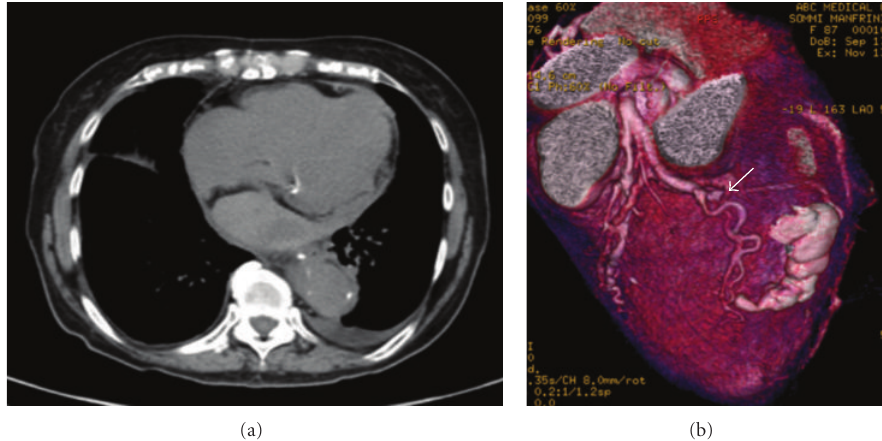
Figure 3: In (a) an important thickening of the pericardium containing the hemopericardium is seen and in (b) the cardiac hybrid CTA image shows a significative obstruction of circumflex artery in its middle segment (white